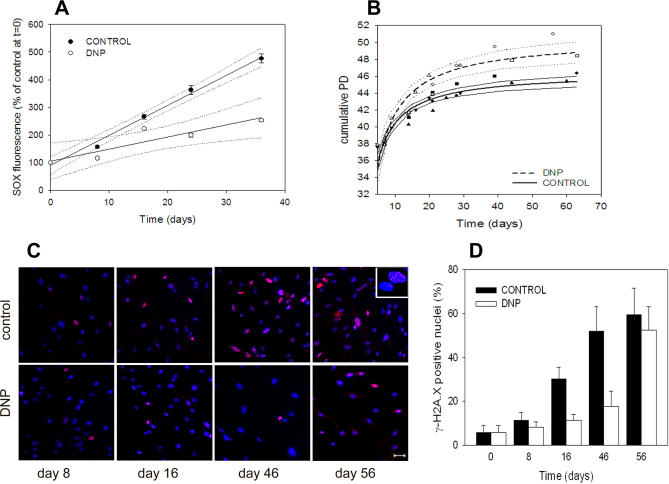
Mild Uncoupling by DNP Prolongs Replicative Lifespan of Human FibroblastsMRC5 fibroblasts were treated with 250 μM DNP from PD 35 till senescence.(A) MitoSOX fluorescence. Data are mean + Δm, n = 2. Fluorescence intensity at t = 0 was set to 100%. Solid line: linear regression, dotted lines: 95% confidence intervals.(B) Replicative lifespan. Data are from three (DNP) respective four (control) independent experiments. Hyperbolic best fits and 95% confidence intervals are shown.(C) γ-H2A.X staining. The bar denotes 20 μm. Insert: higher magnification showing focal staining.(D) Frequency of γ-H2A.X-positive fibroblasts. Data are mean ± s.d., n = 3. Differences are significant (p < 0.05) between day 8 and 46.